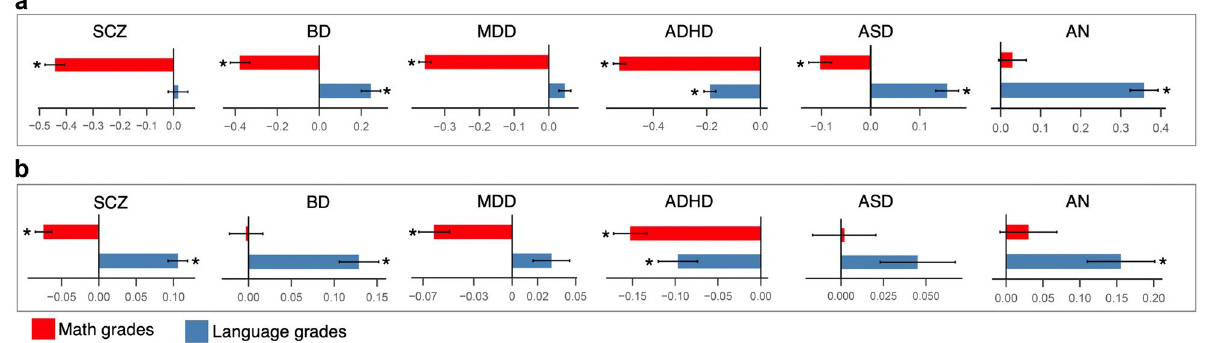
Figure 4. Phenotypic and genetic associations of math and language grades with psychiatric disorders. ( a ) Phenotypic associations of math and language grades with the six disorders tested using multiple logistic regression; standardized effect sizes (beta) and standard errors are shown; ( b ) Associations of polygenic scores for the six psychiatric disorders with math and language grades analyzed only in the controls (N = 12,487); standardized effect sizes (beta) and standard errors are shown. Star symbols indicate statistical significance after multiple testing corrections (P < 0.004). SCZ schizophrenia, BD bipolar disorder, MDD major depressive disorder, ADHD attention deficit hyperactivity disorder, ASD autism spectrum disorder, AN anorexia